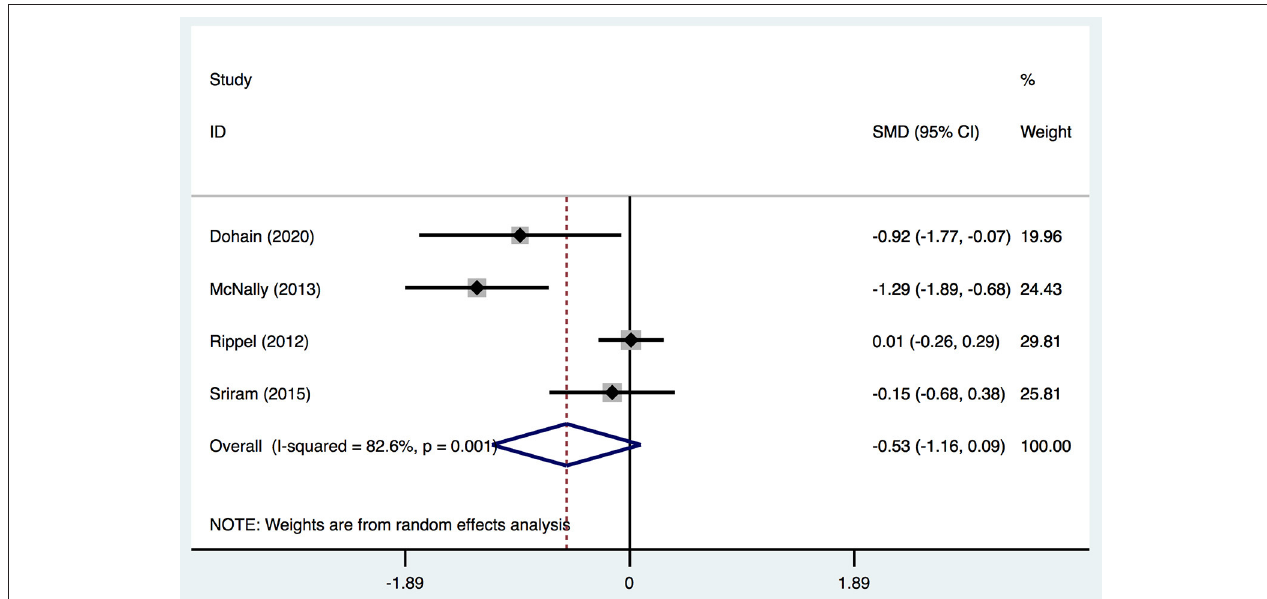
FIGURE 7 | Forest plot for the relationship between VitD level and ICU stay duration in the meta-analysis of four trials using random-effect model. Only the first author of each study is given. Test for overall effect, z = 1.67, P = 0.096; test for heterogeneity, I 2 = 82.6%, P = 0.001. SMD, standard mean difference. CI, confidence interval.